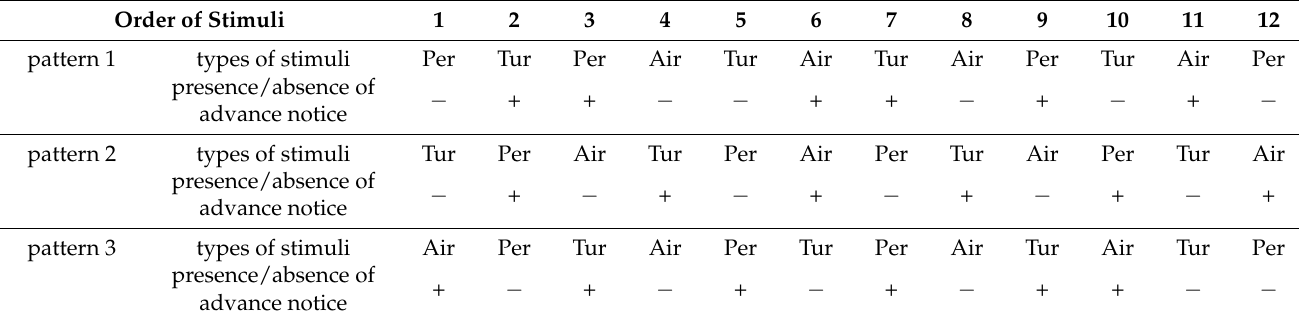
Table 1. Paterns of stimulation used for simulated dental